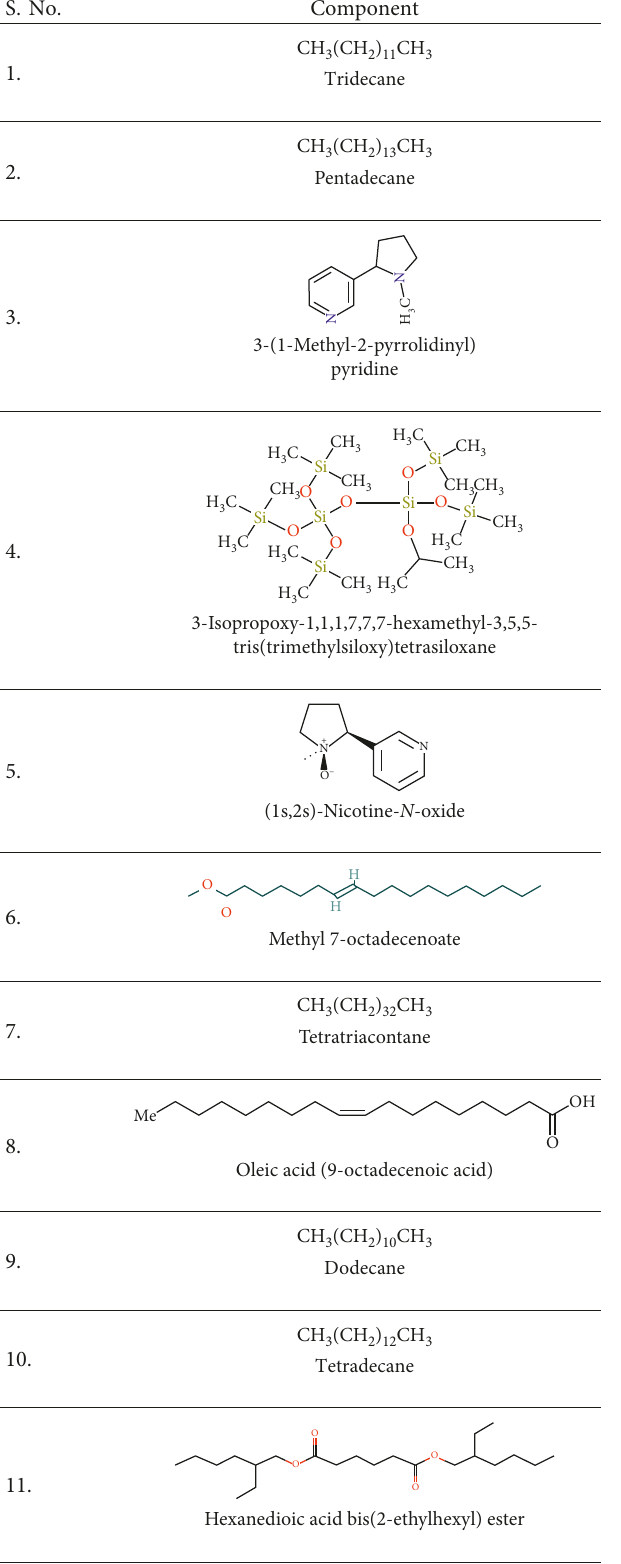
Table 1: The chemical formula/structure of toxic/carcinogenic components identified in various shammah types using GC-MS. S.